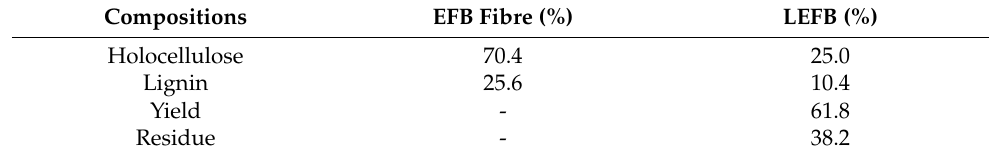
Table 1. Compositions of oil palm empty fruit bunch (EFB) fibre and after liquefaction.